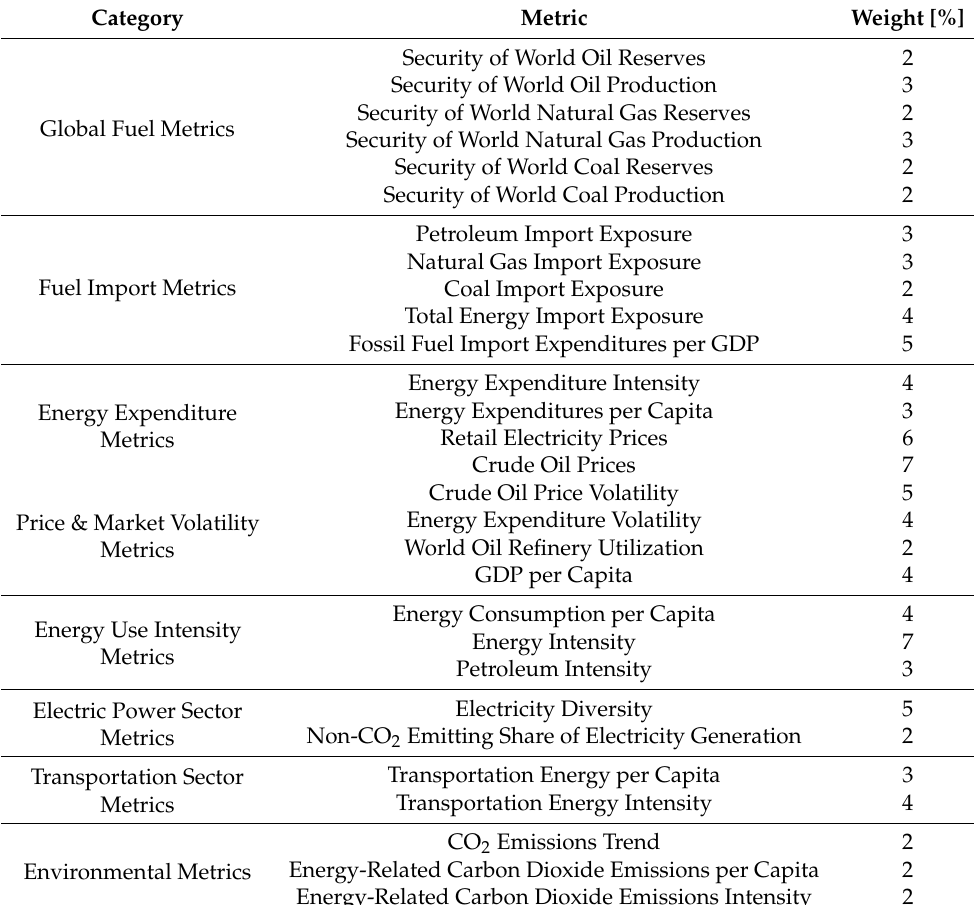
Table 3. Metrics Used to Create International Index of Energy Security